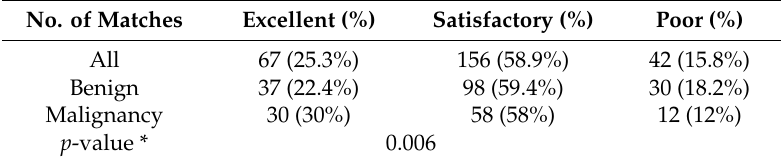
Table 1. Quality of CAD system nodule segmentation.